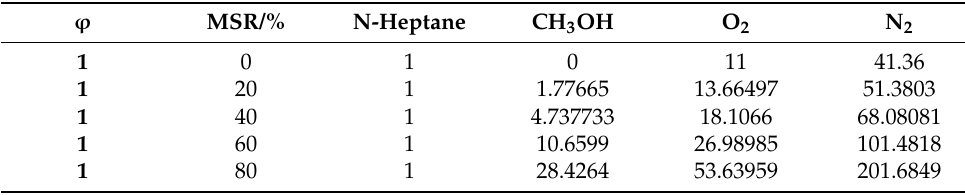
Table 3. Simulation conditions (% molar volumes of each constituent).